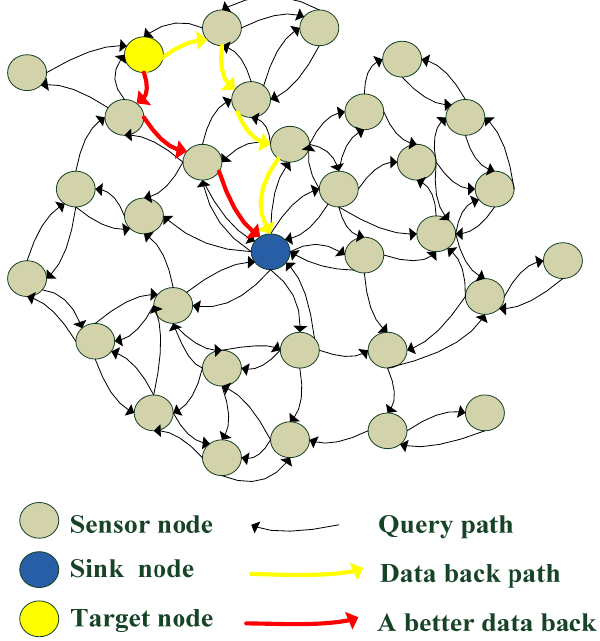
Figure 2. Sink node searches for target node and the target sends data back to sink node. The query path is disordered and the data back path is not the best. Intermediate nodes rebroadcast the packet